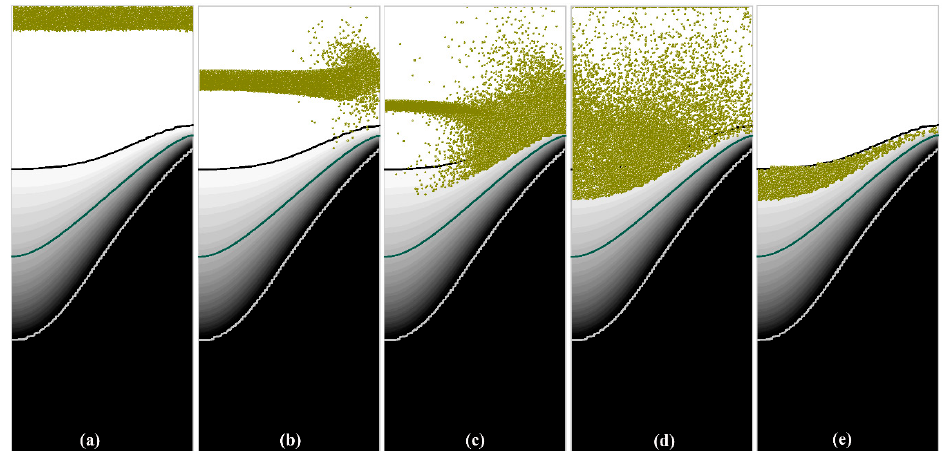
Figure 2. Numerical procedure for obtaining the initial distribution of the particles in DC casting, ( a ) particles injection, ( b – d ) motion and distribution of the particles at different calculation times, ( e ) particles distribution within 0 < f s < 0.1.